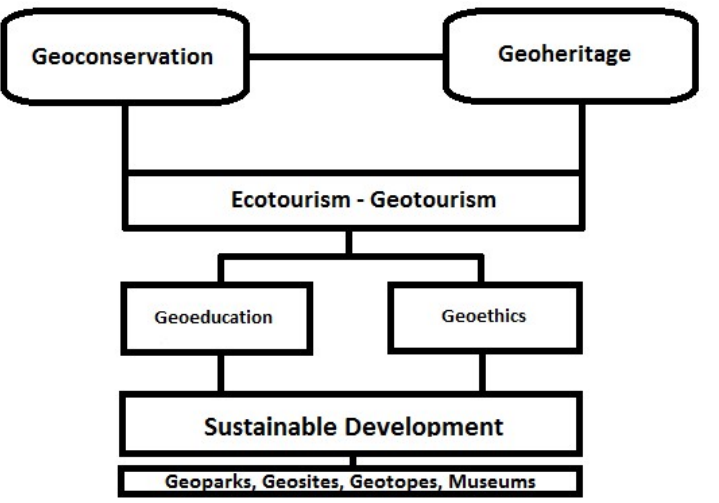
Figure 3. Interconnection and components of rational use between geoconservation and geoheritage.